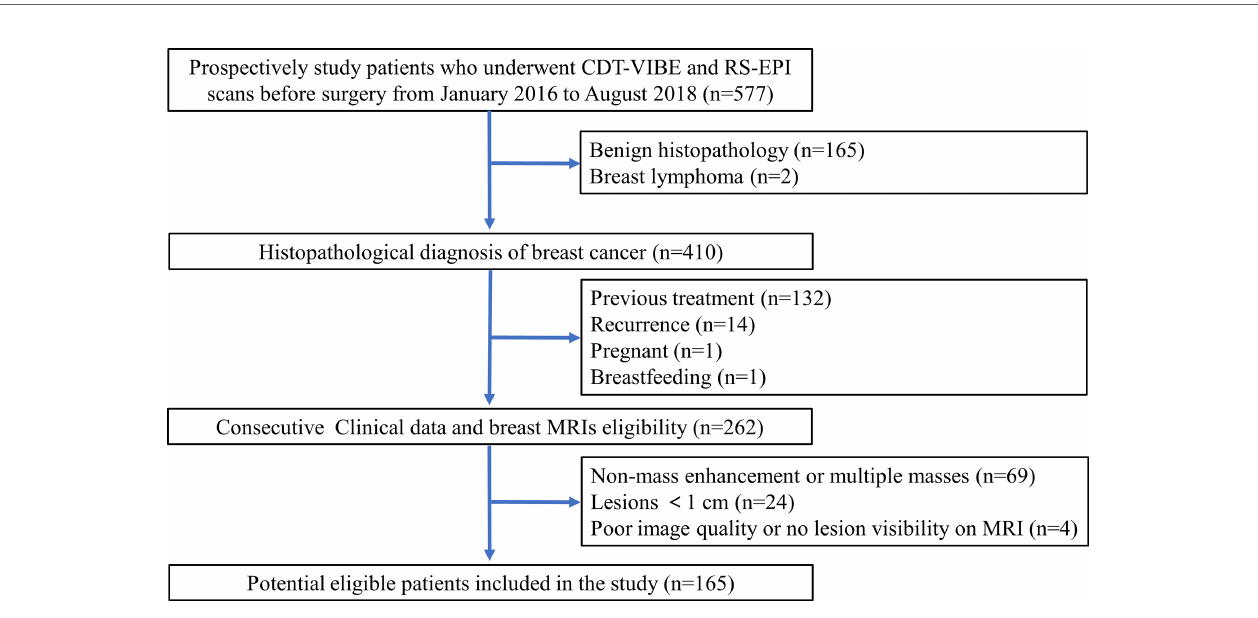
FIGURE 1 | Patient selection fl ow